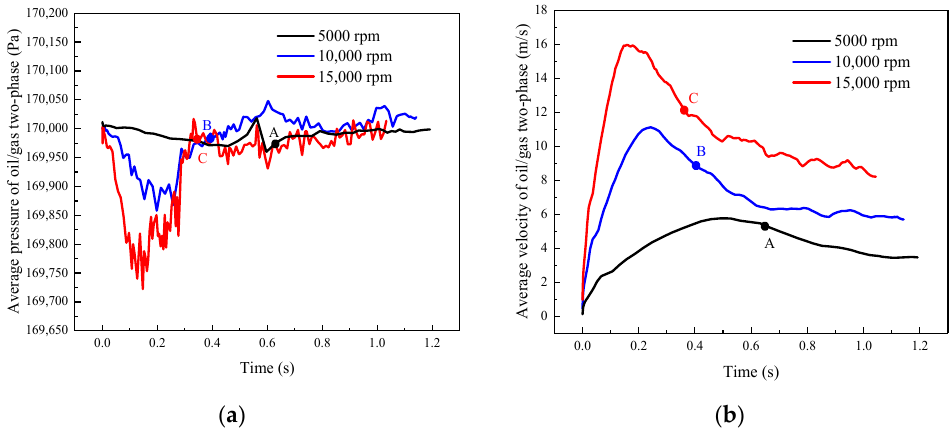
Figure 11. Average pressure ( a ) and average velocity of oil/gas at different rotor speeds ( b ).